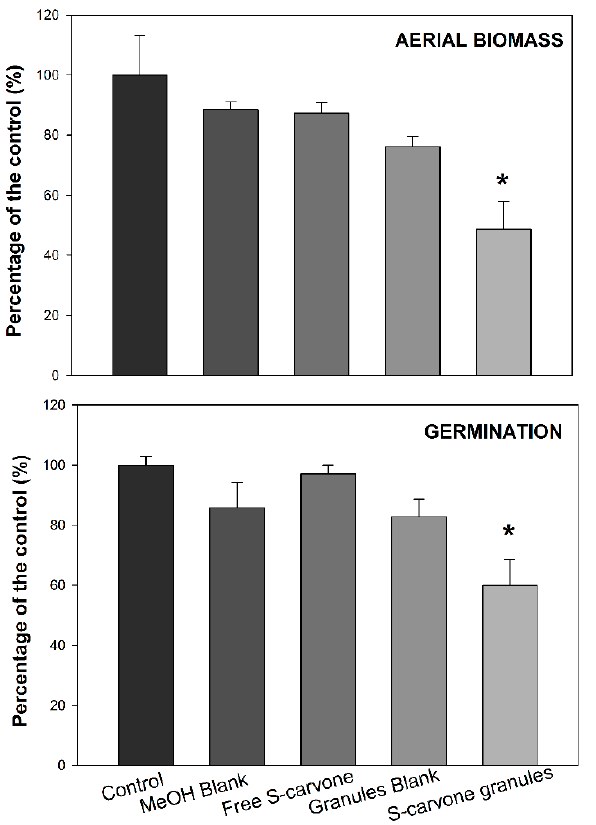
Figure 5. Effect of S-carvone applied as free compound or supported on granules on aerial biomass and germination of Lactuca sativa L. in the soil after 7 days of treatment. Bars are means and standard errors for n = 3. The asterisk indicates significant differences between the treatments and the control at statistical level p < 0.05.